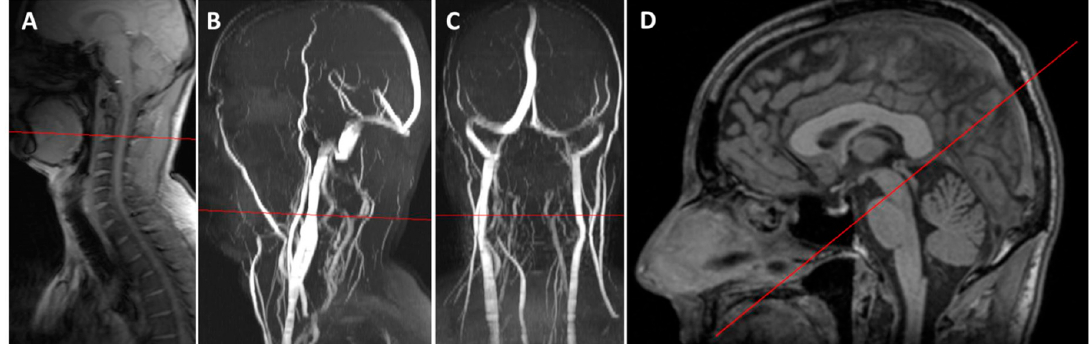
Figure 1. Slice positioning of the slice of the PC sequences (red). Sagittal neck localizer ( A ) for the positioning the PC slice at the C2–C3 level and quantifying the blood flow and the cCSF. Sagittal ( B ) and coronal ( C ) MIP for positioning the slice perpendicularly to the venous blood flow. Sagittal T1-weighted image ( D ) for positioning the aqueductal PC perpendicularly to the AoS. This subject is an exemplificative typical one (subject 5005).